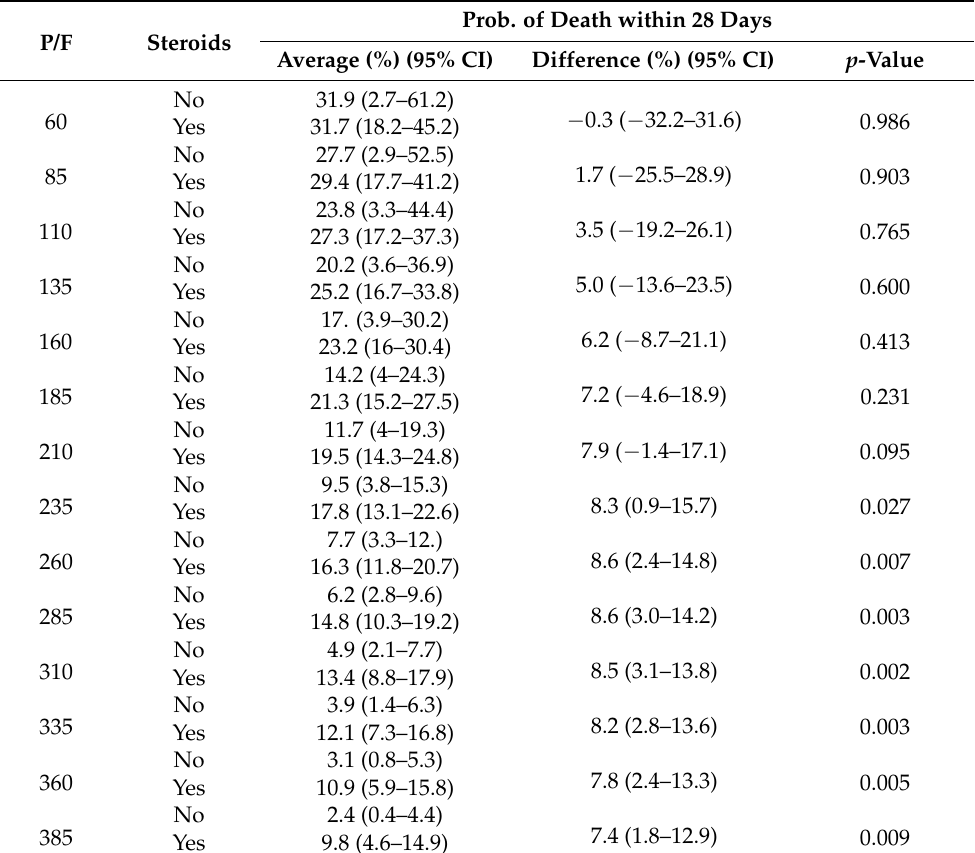
Table A1. Estimated margins of probability of death within 28 days with respect to P/F for exposed and unexposed cohorts. Difference column explains the steroid effect.